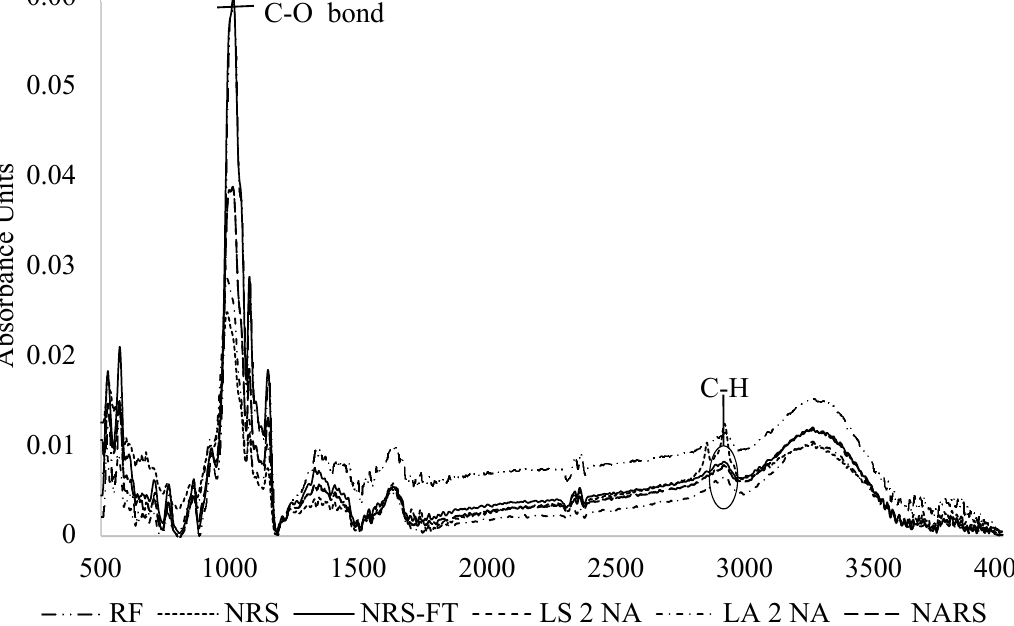
Figure 5. Fourier Transform Infrared (FTIR) spectra of the RD 31 rice flour, native starch, and modified starches. RF = Rice flour. NRS = Native rice starch. NRS – FT = Native rice starch: freeze